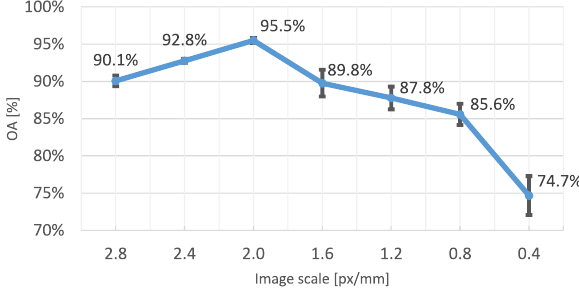
Figure 6. Results achieved at different image